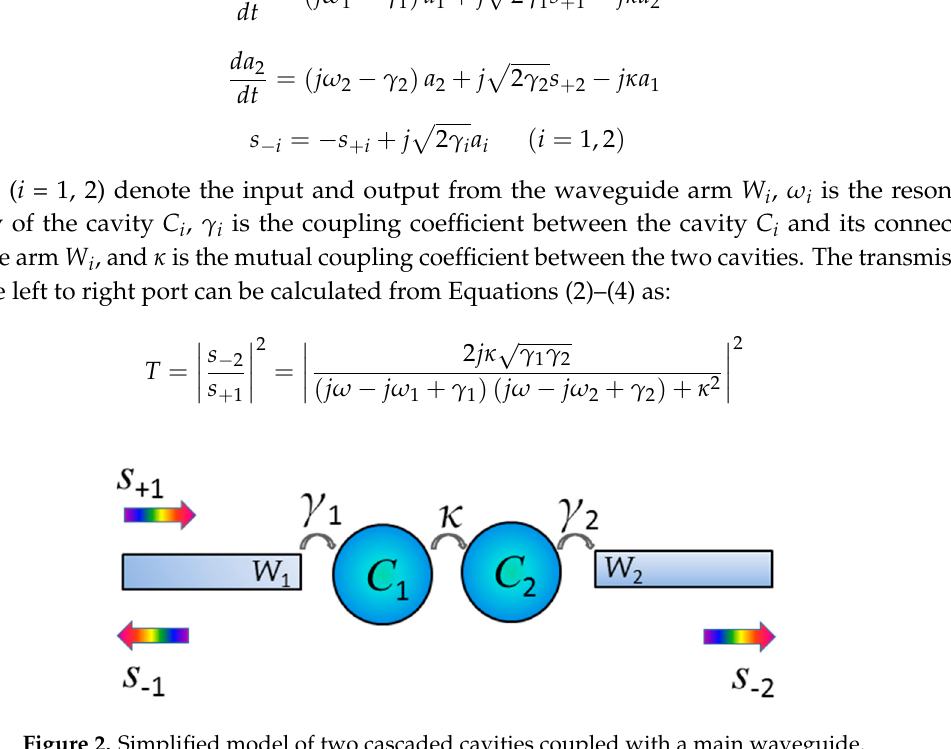
Figure 2. Simplified model of two cascaded cavities coupled with a main waveguide.